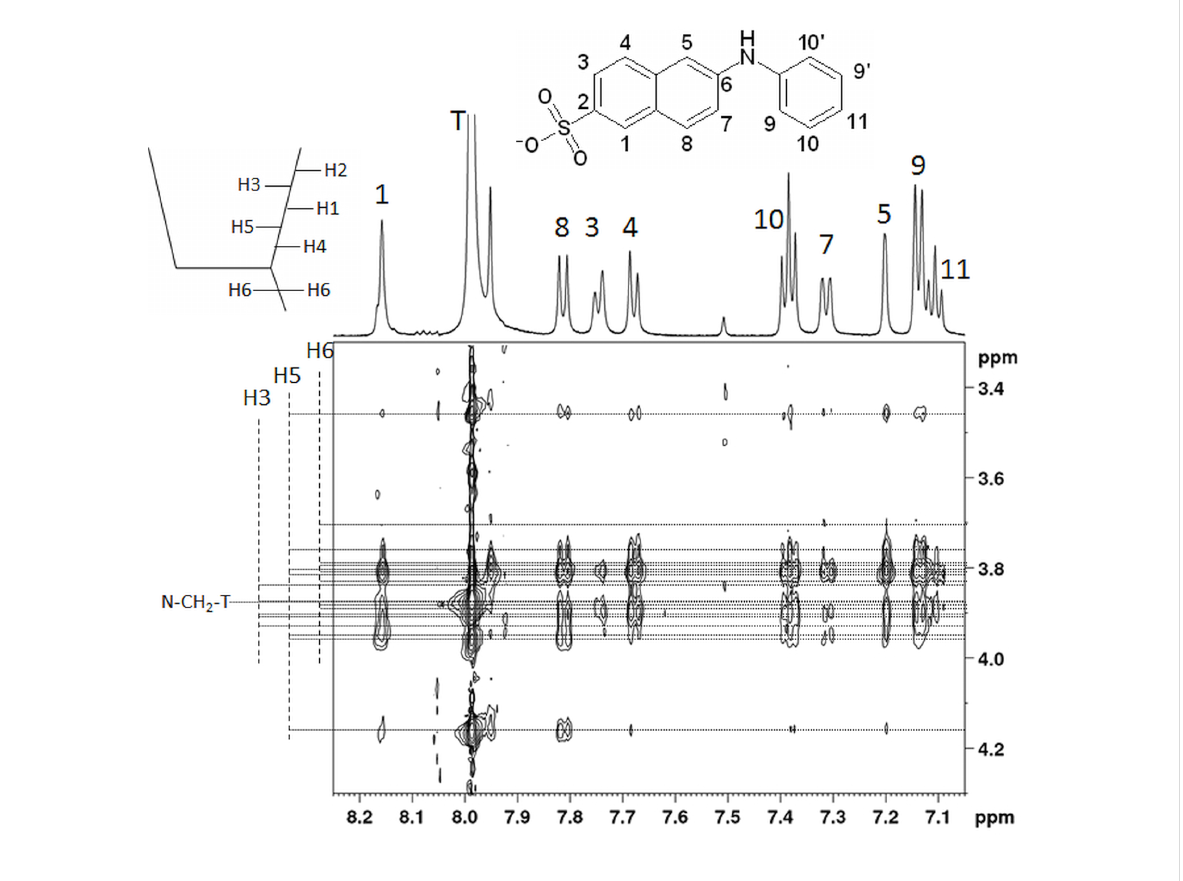
Figure 5: Region of interest of a ROESY (250 ms mixing time) showing cross peaks between the β -CD-dimer and 2,6-ANS. The corresponding region of the 1 H NMR spectrum of the mixture is shown above the 2D plot. The signal marked “T” is related to the single proton attached to the triazole ring. Dotted, horizontal lines indicate the positions of the β -CD H3, H5 and H6 resonances of the mixture: the lines extending furthest to the left correspond to H3 atoms, lines extending least to the left side correspond to H6, lines of intermediate length belong to resonances of H5. Dashed, vertical lines and their corresponding label also indicate to which atom the resonances belong. The resonance marked “N-CH 2 -T” comes from the CH 2 group between the triazole moiety and the nitrogen atom connecting the two β -CD